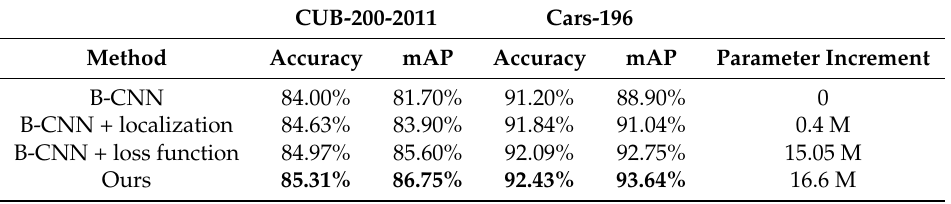
Table 4. Classification accuracy and mAP of different models on Cars-196 and CUB-2011, as well as the additional computation of these